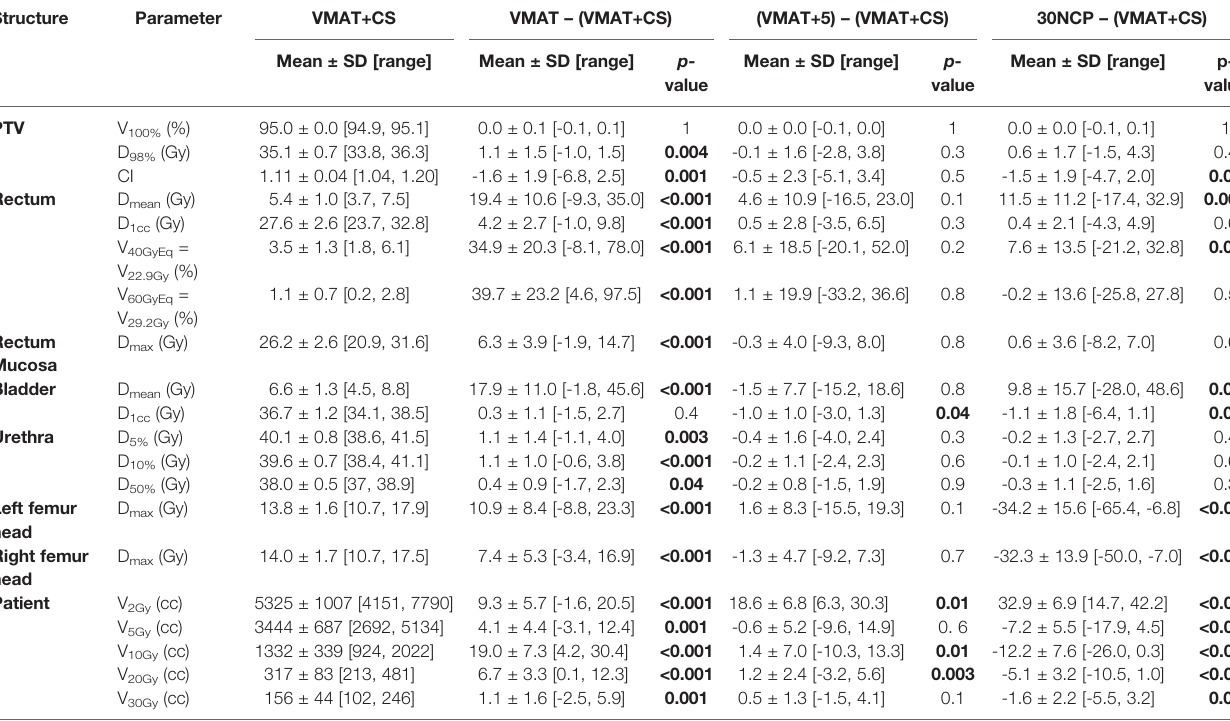
TABLE 2 | Comparison of dosimetric plan parameters of VMAT+CS with VMAT, VMAT+5, and 30-NCP plans for all study patients. Structure